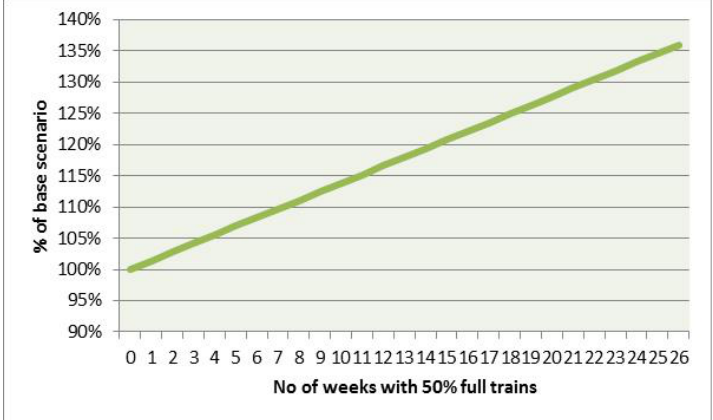
Figure 10. Increasing costs based on number of weeks with 50% full